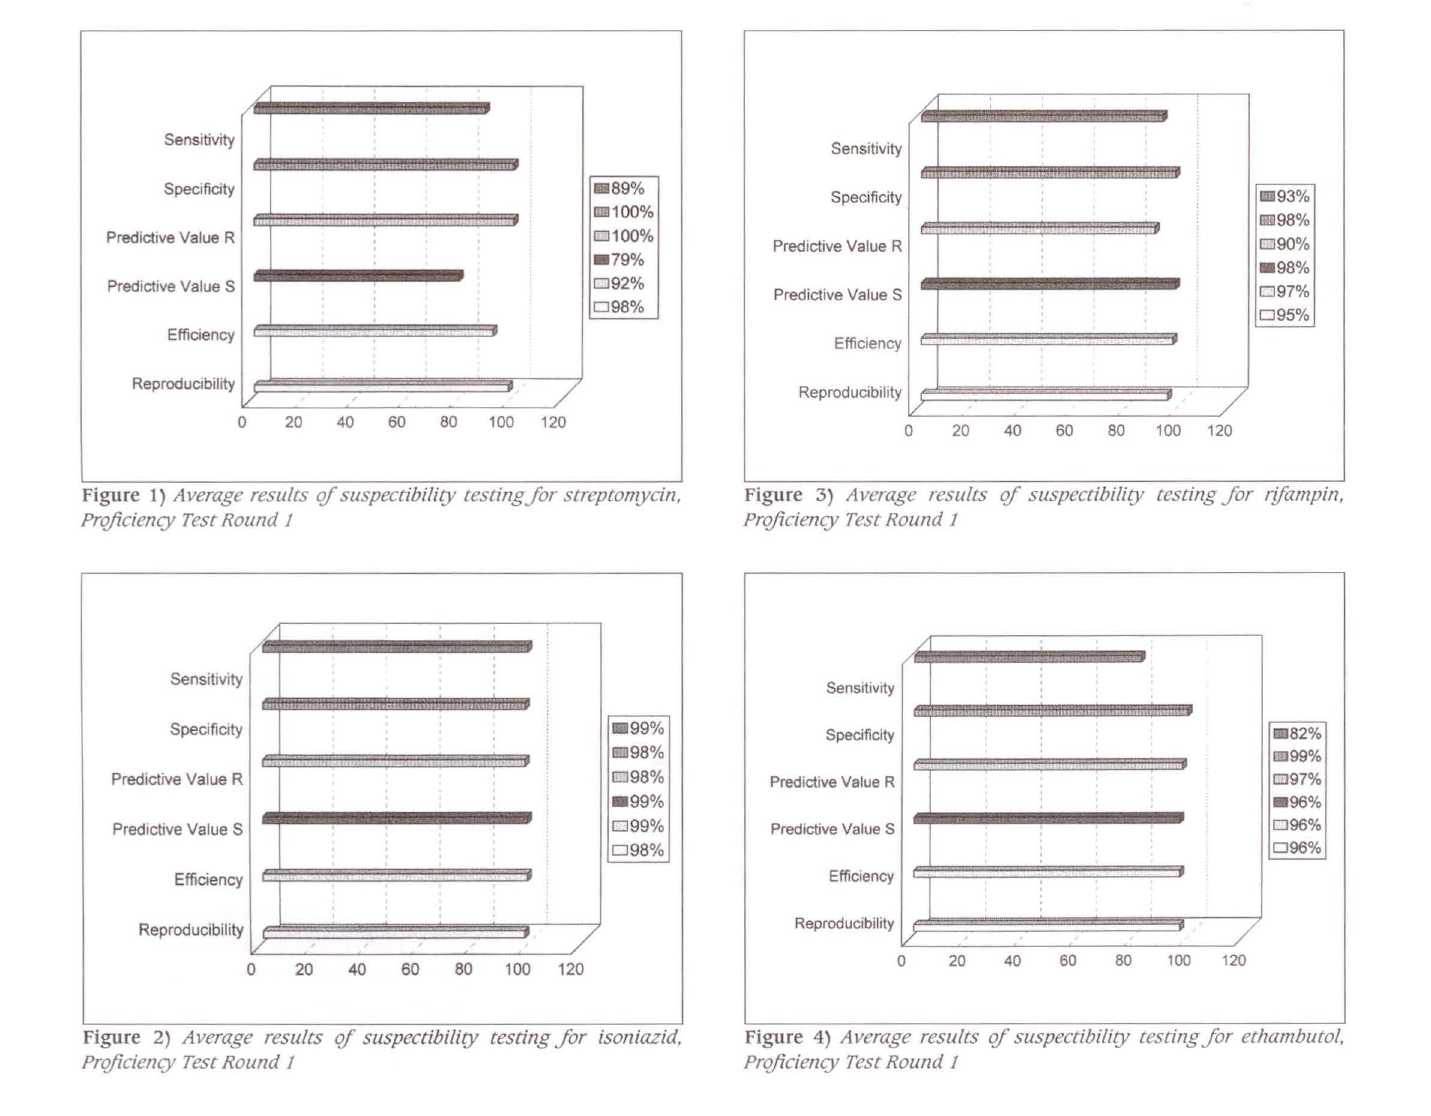
Figure 3) Average results qf suspectibility testing Jor